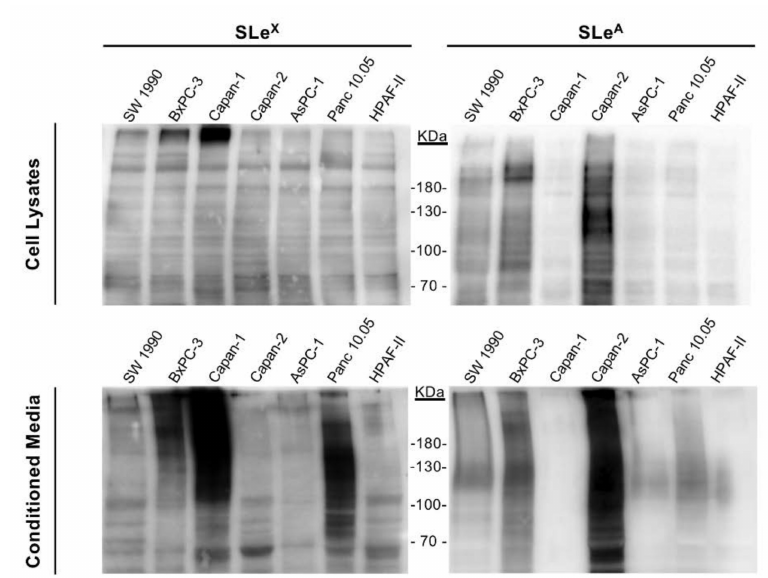
Figure 2. Immunodetection by Western blot of sLe x (left) and sLe a (right) content in proteins from total cell lysates (top) and conditioned media (bottom) of the PDA cells. Blots were probed with clones CSLEX1 mAb against sialyl-Lewis x and the clone 57 / 27 mAb against sialyl-Lewis a.